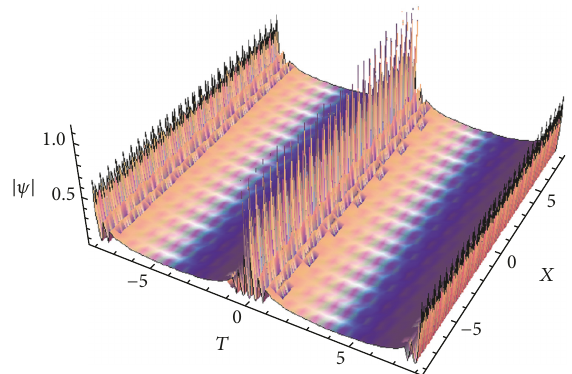
Figure 15: Spatial structure of the module of solution (81) with 𝑘 = 10 .